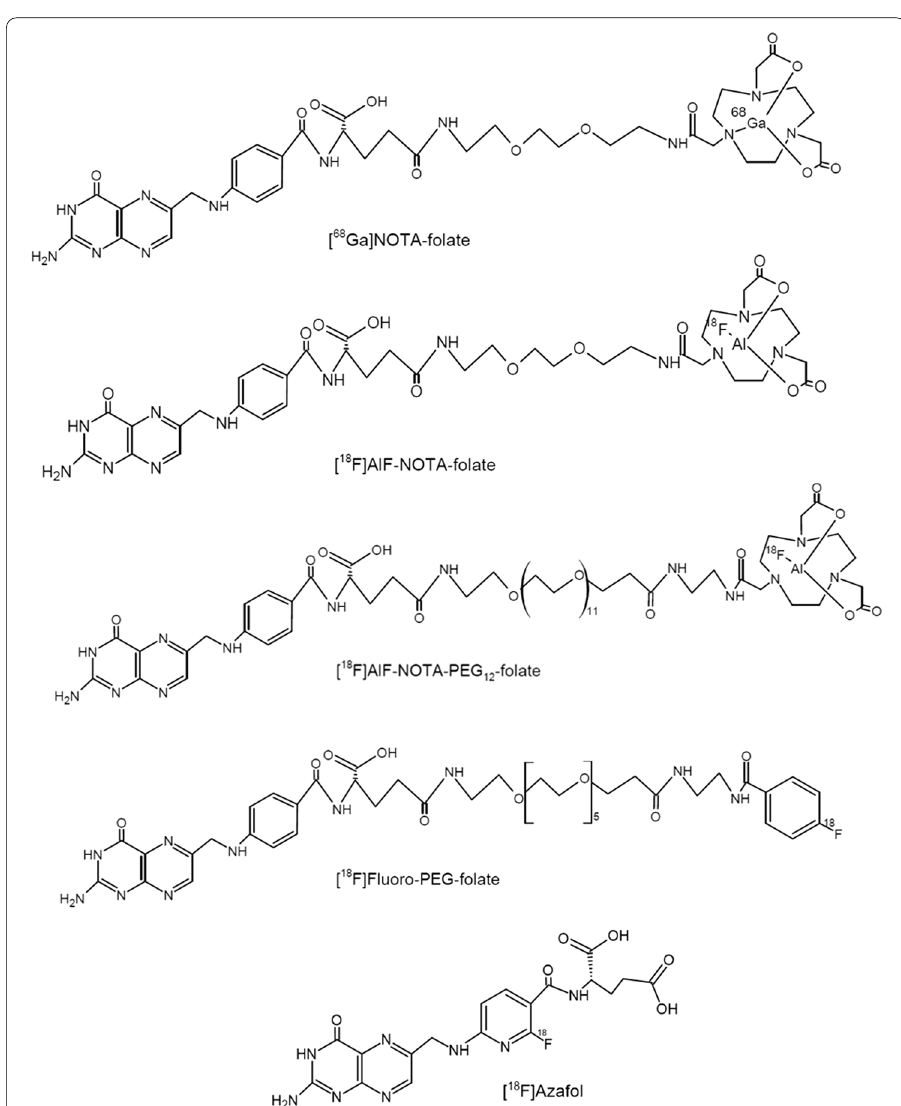
Fig. 5 Structures of representative candidate tracers for FRβ. FRβ: folate receptor